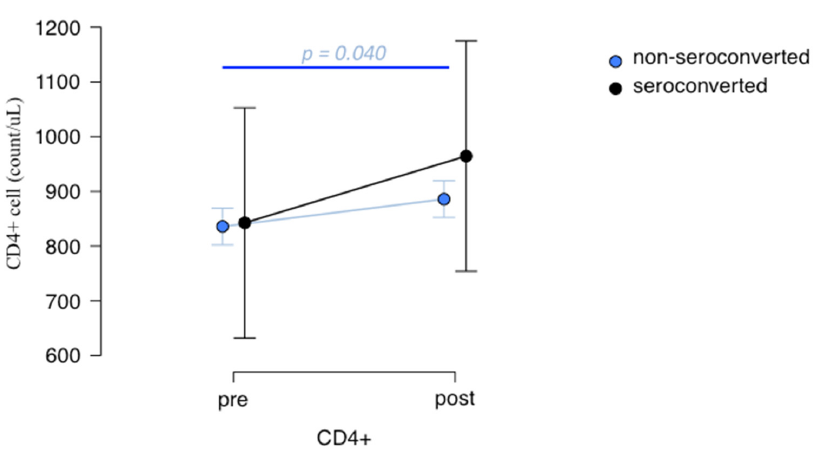
TNF- α (although a mild trend towards increasing was evident, p = 0.196) serum levels pre- and (Student’s paired t -test).